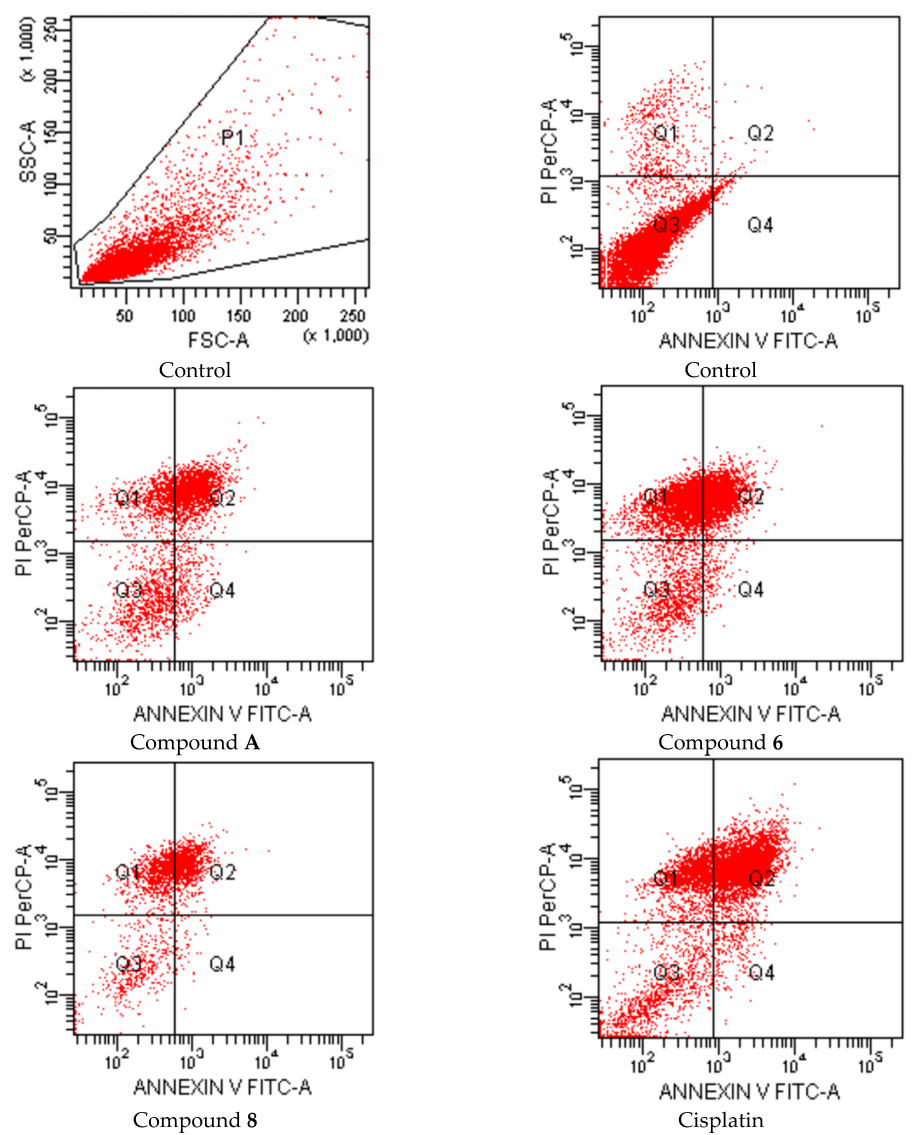
Figure 1. Flow cytometric analysis of A549 cells treated with IC 50 values of compounds A , 6 , 8 , and cisplatin for 24 h. At least 10,000 cells were analyzed per sample, and quadrant analysis was